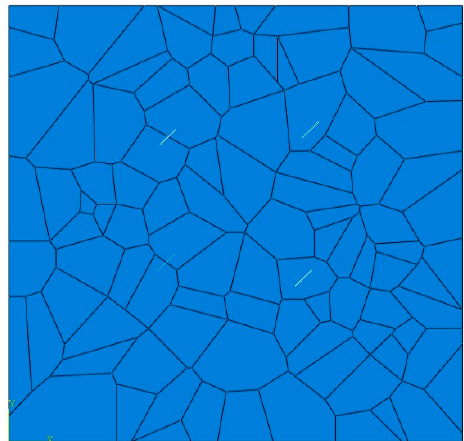
Figure 6. Crack position distribution diagram of the crack with the tensile stress at an angle of 45°.